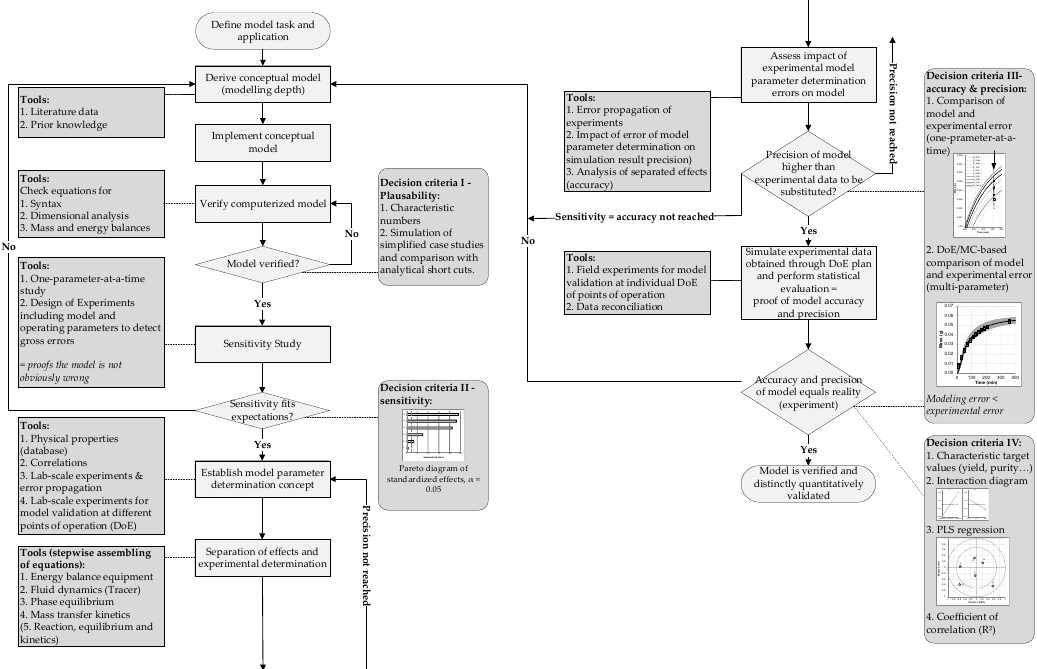
Figure 3. Process model development workflow. Adapted from [12].